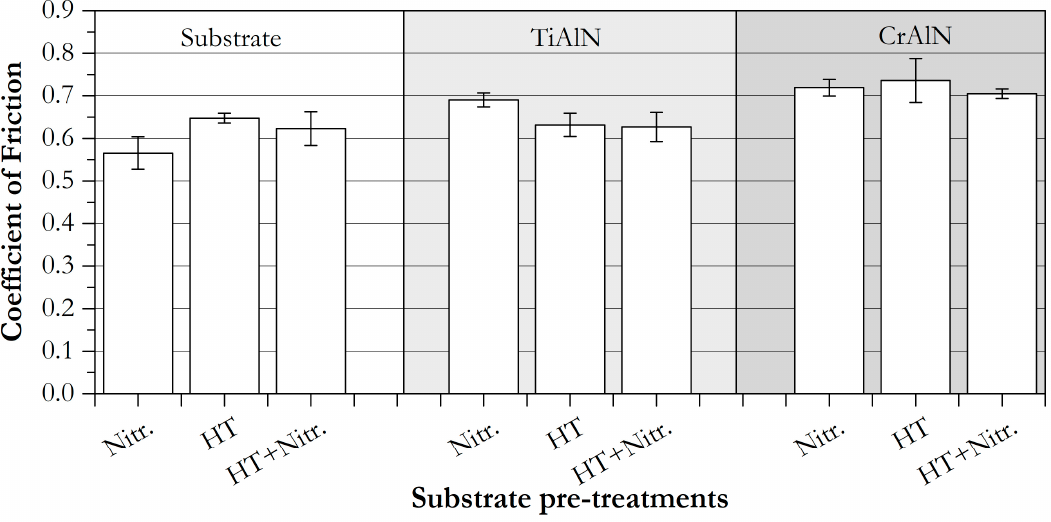
Figure 11. Wear coefficients of the substrates after pre-treatments and of the coatings.